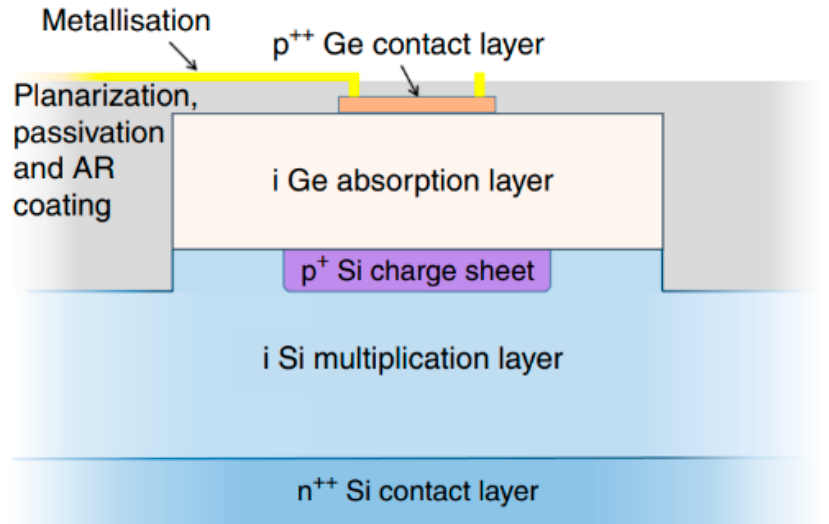
Figure 21. Cross-section diagram of a planar Ge/Si SPAD structure with an i-Ge absorption layer, a p + -Si charge layer, and a i-Si multiplication layer. Reproduced from [77,78], ROS Theses Repository, and Springer Nature, open access, 2019.